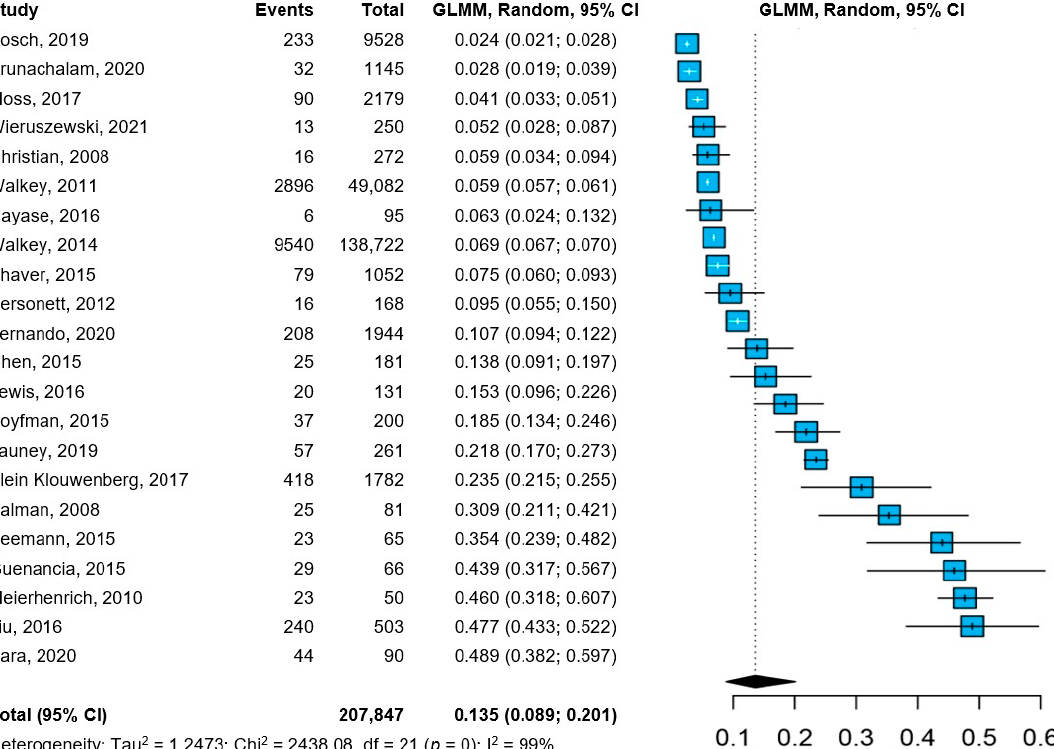
Table 2. Subgroup analysis of NOAF prevalence in patients with